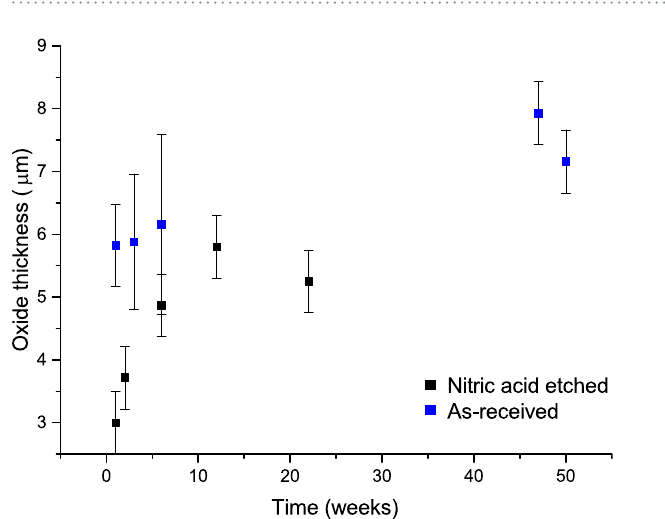
Figure 4. A plot demonstrating the change in UO 2 thickness on each uranium sample when exposed to water vapour over time. Values and errors are extracted from Table